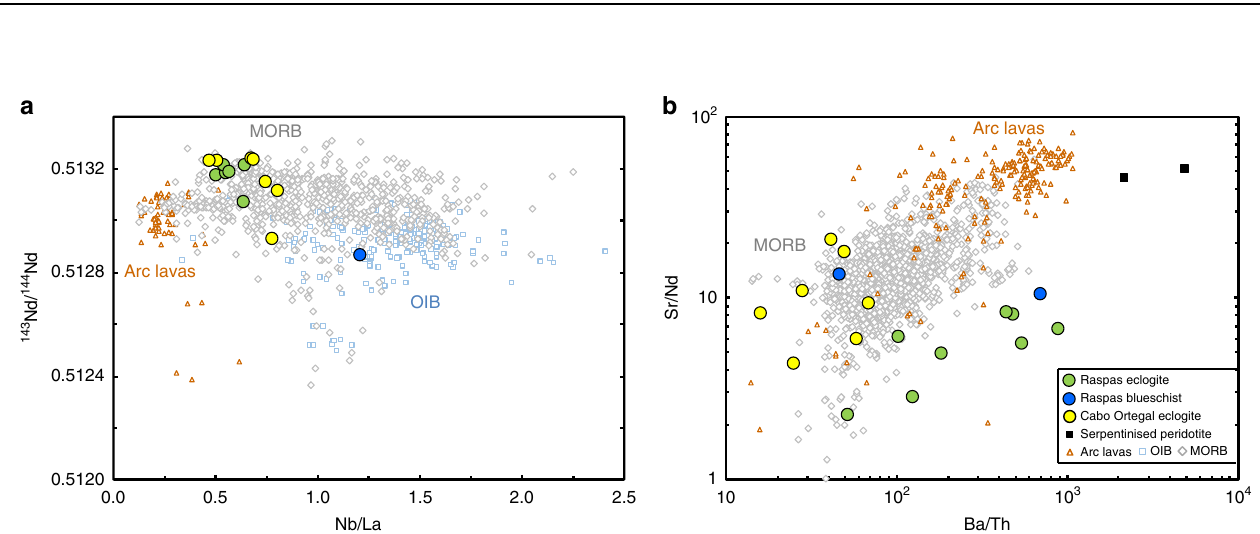
Fig. 1 Protoliths and subduction modi fi cation of studied eclogites and blueschists. a 143 Nd/ 144 Nd versus Nb/La (weight ratio). These fl uid immobile elements should be little in fl uenced by fl uid loss during subduction and so re fl ect protolith compositions. b Sr/Nd vs Ba/Th (weight ratios). These two ratios of fl uid mobile over fl uid immobile elements of similar magmatic incompatibility show the effects of subduction zone processes. Most of the meta- basalts have low Sr/Nd relative to mid-ocean ridge basalts (MORB), complementary to elevated Sr/Nd in arc lavas. Their Ba/Th are more variable, including some low values but ranging to higher values re fl ecting late phengite addition. Data sources: MORB is from compilation in ref. 70 , ocean island basalts (OIB) and volcanic arc lavas compiled from PetDB (http://www.earthchem.org/petdb); Trace elements and Nd isotopes of samples from this study compiled from ref. 23,27,40 (see Supplementary Table 1), except for Nd isotopes of Cabo Ortegal Complex measured in this study